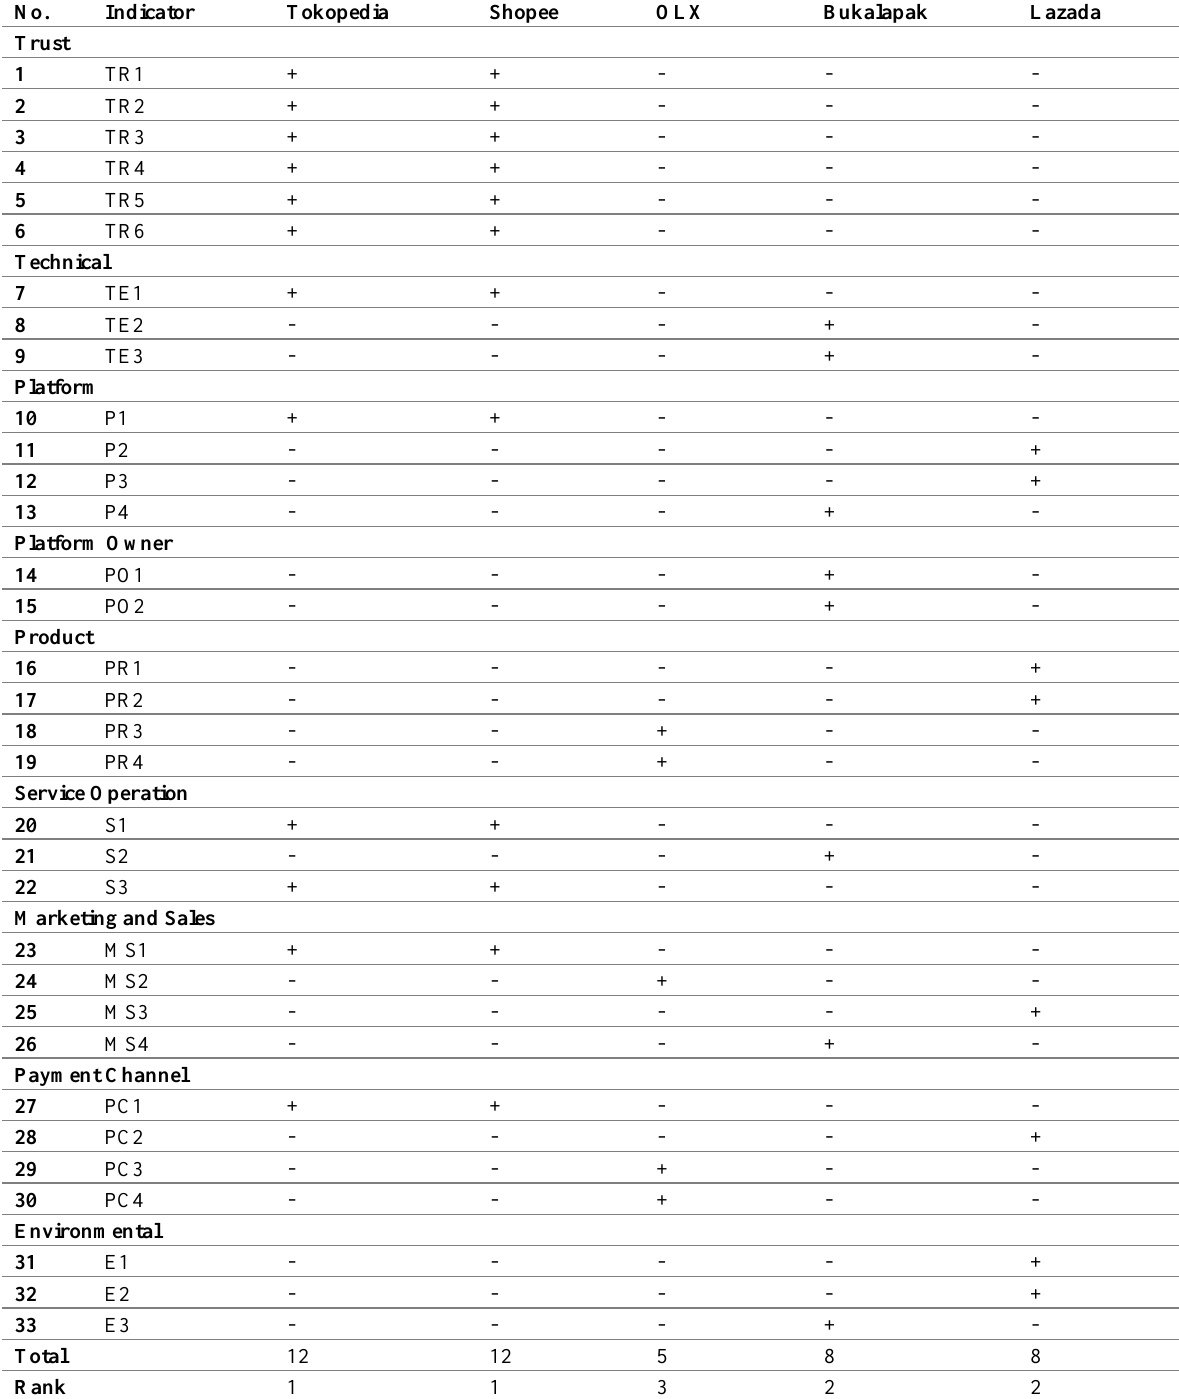
Table 5: E-Marketplace